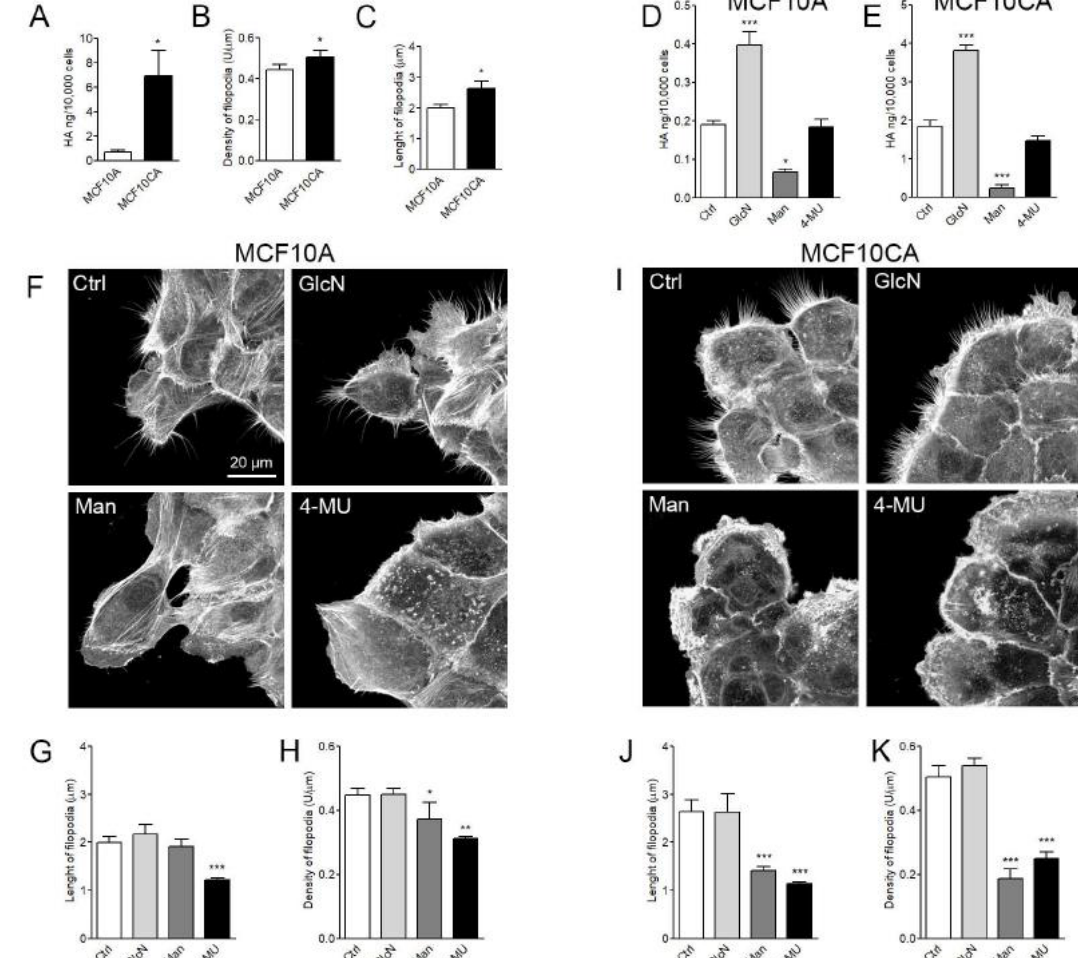
Figure 7. Hyaluronan (HA) secretion and filopodial growth in MCF10A and MCF10CA breast cancer cell lines. ( A ) HA secretion levels, ( B ) density, and ( C ) length of filopodia of fixed and phalloidin-stained MCF10 cell lines. Effect of different treatments on hyaluronan secretion of ( D ) MCF10A and ( E ) MCF10CA cells. ( F ) Examples of MCF10A cell cultures and ( I ) MCF10CA cell cultures after different treatments. ( G ) Average length and ( H ) density of filopodia in MCF10A cells, and ( J ) length and ( K ) density of filopodia in MCF10CA cells after different treatments. Ctrl = control, GlcN = glucosamine (2 mM), Man = mannose (20 mM), and 4-MU = 4-methylumbelliferone (1 mM). Student’s t -test was utilized to compare the cell lines (A–C) and one-way ANOVA compared the treatments (D, E, G, H, J and K). * p < 0.05, ** p < 0.01, *** p < 0.001 ( n = 5 independent experiments with 18–43 cells/group in each experiment).